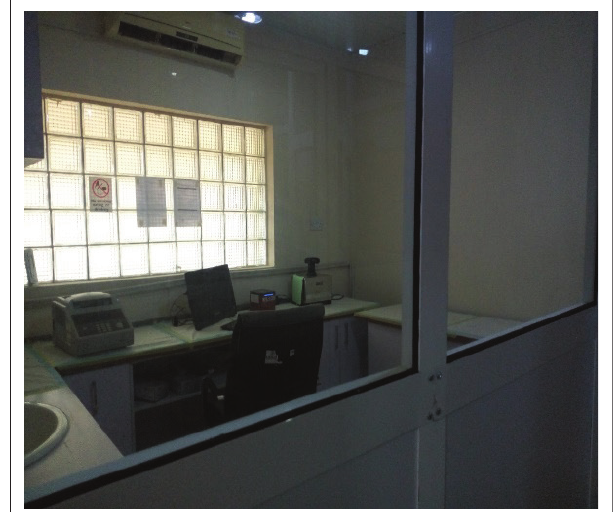
FIGURE 3: Amplification and detection room for real-time detection of nucleic acid, Edo state, Nigeria,